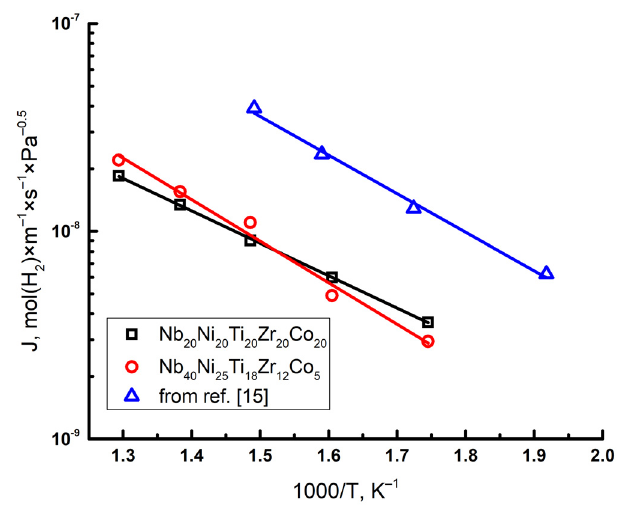
Figure 4. Hydrogen permeability of HEAs depending on temperature.